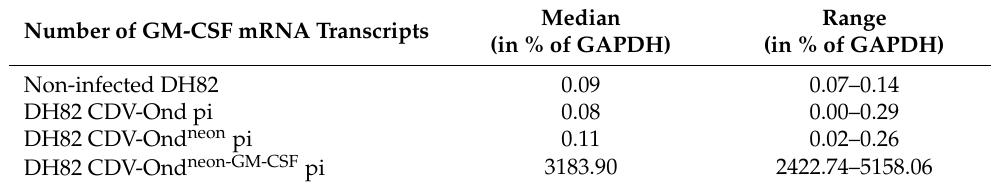
Table 3. Median and range of the number of GM-CSF mRNA transcripts in % of GAPDH. Number of GM-CSF mRNA Transcripts Non-infected DH82 0.09 0.07–0.14 DH82 CDV-Ond pi 0.08 DH82 CDV-Ond neon pi 0.11